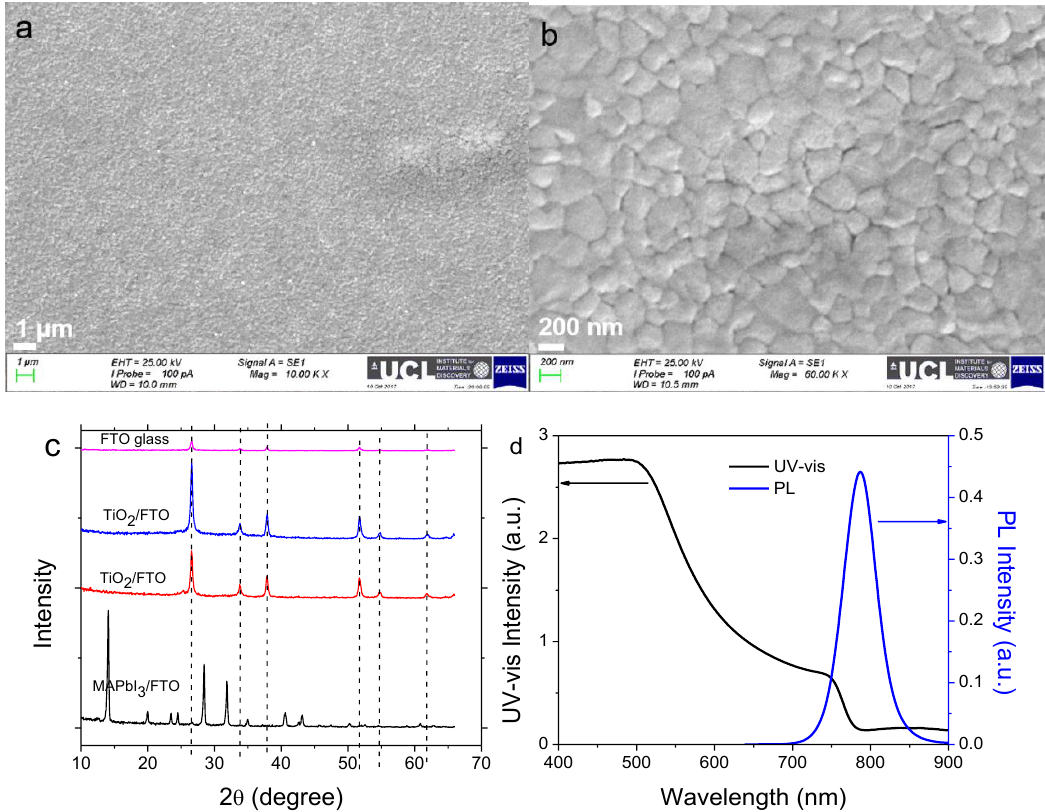
Figure 1. ( a , b ) scanning electron microscopy (SEM) images of MAPbI 3 annealed on fluorine-doped tin oxide (FTO) glass, ( c ) X-ray diffraction (XRD) pattern of perovskite MAPbI 3 and TiO 2 on FTO glass and ( d ) UV-vis and photoluminescence (PL) spectra of MAPbI 3 perovskite on a bare glass substrate.